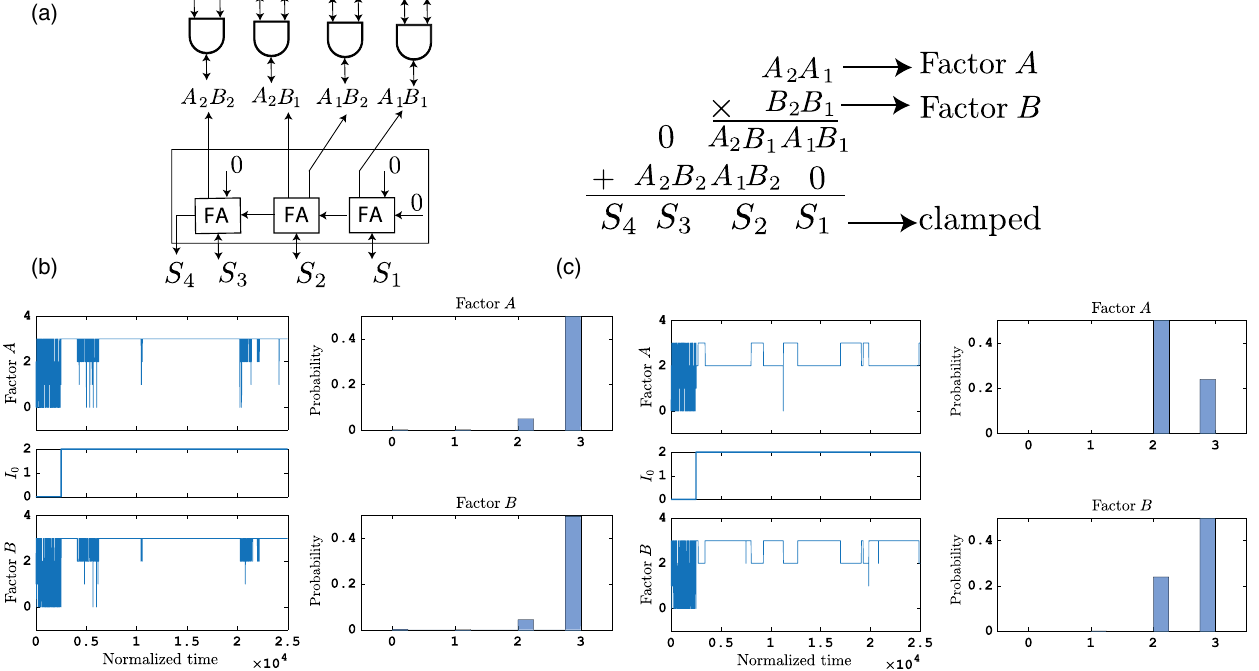
FIG. 16. Factorization through inverse multiplication. The reversibility of PSL allows the operation of integer factorization using a binary multiplication circuit implemented using the principles of digital logic using AND gates and full adders, as shown in (a). The output nodes of a 4-bit multiplier are clamped to a given integer, and the system produces the only consistent factors of the product at the input terminals, probabilistically. The interaction parameter I 0 is suddenly increased to a saturation value of 2, and held constant as shown. (b) The output terminal is clamped to 9 and is factored into 3 × 3 ; note that 9 × 1 is not an achievable solution in this setup since encoding 9 requires 4-bit inputs in binary, whereas inputs are limited to 2-bits. (c) The output terminal is clamped to 6 and after being correlated, the factors cross-oscillate between 2 and 3. In both cases the histogram is obtained by counting outputs after t > t = 2 ¼ 1 . 25 × 10 4 time steps to collect statistics after the system is total